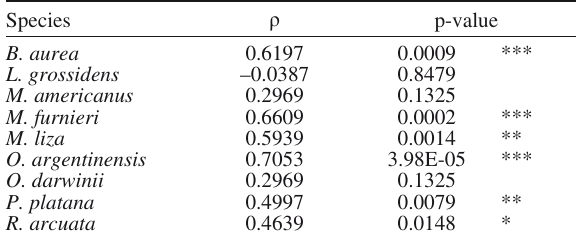
Table 6. – Spearman rank correlation coefficients ( r ) between fish juvenile abundance and wave period (seconds between consecutive waves) of the species collected in the surf zone during the study pe- riod. * (p<0.05), ** (p<0.01) and *** (p<0.001) denote significant